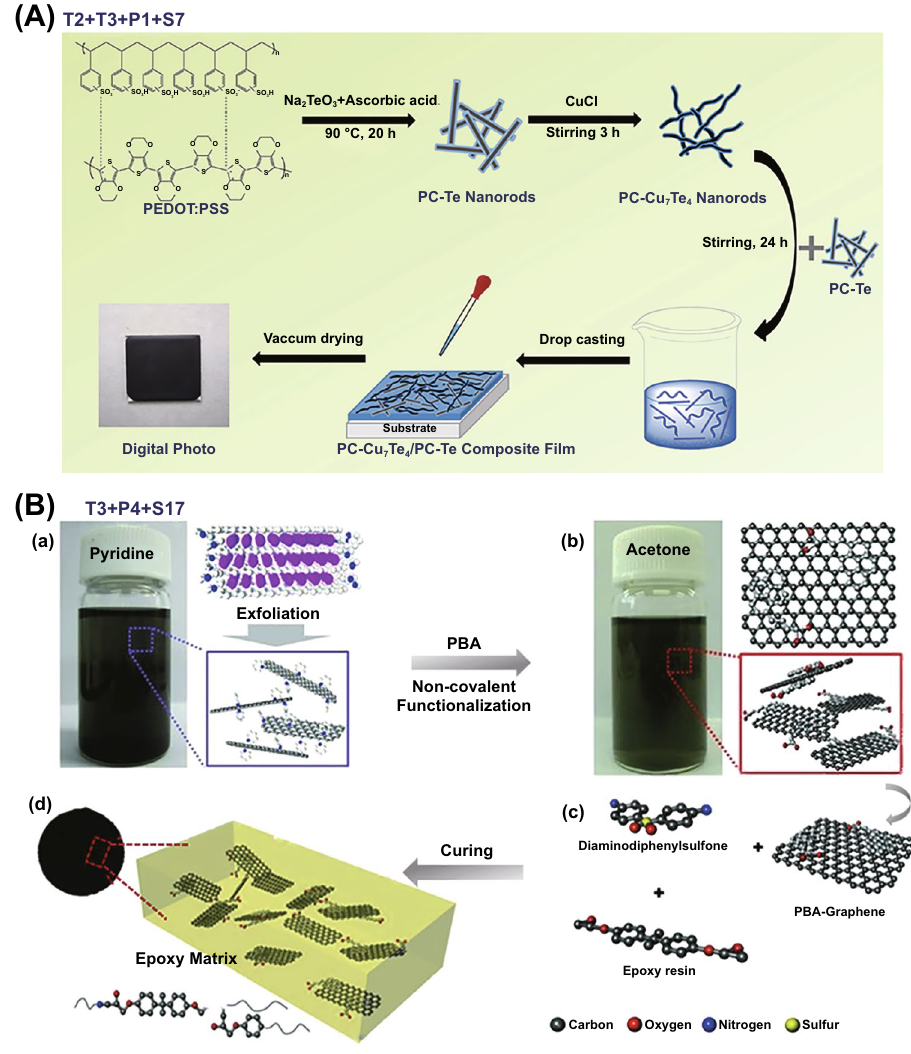
Fig. 13 A Schematic illustration of the fabrication process for polycarbonate (PC)/Te/Cu 7 Te 4 thermoelectric composites. Reprinted with per- mission from Ref. [183]. B Schematic plot of the fabrication for epoxy/f-GFs composites. Reprinted with permission from Ref.